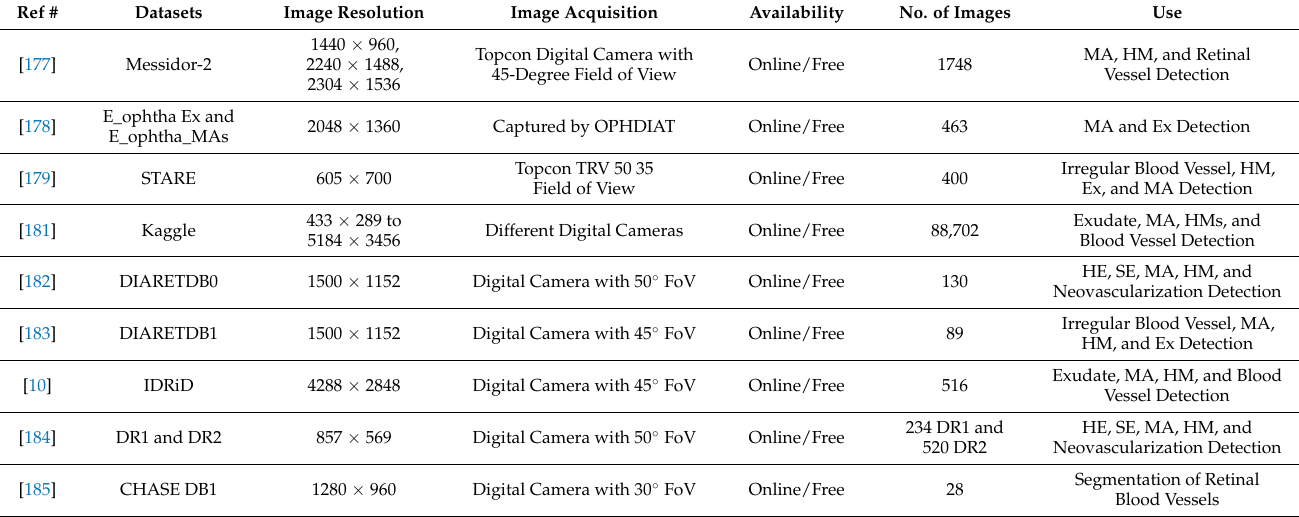
Table 7. Description of DR